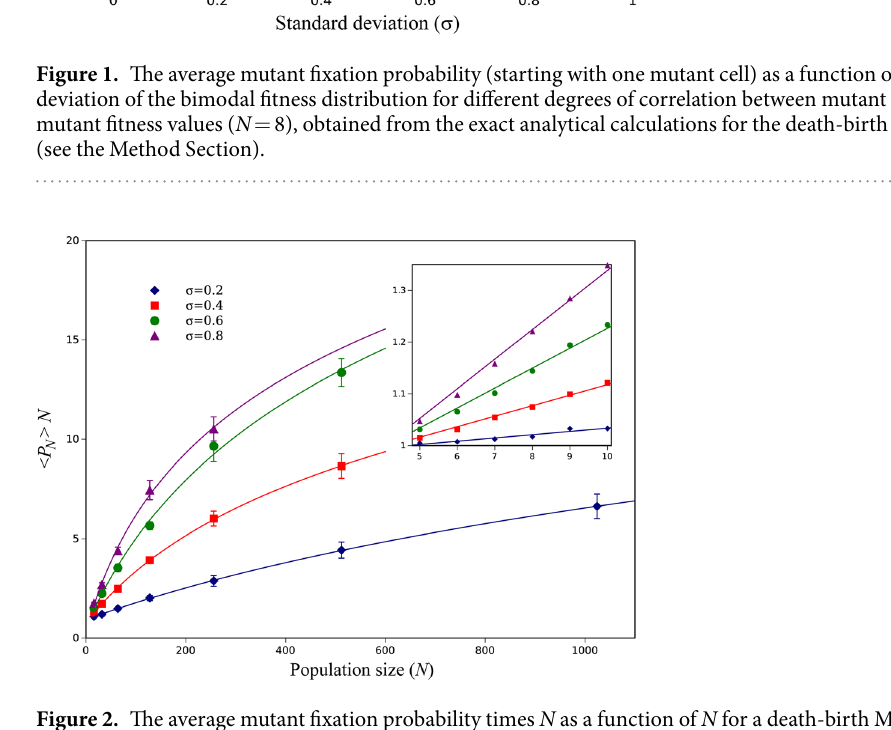
Figure 2. The average mutant fixation probability times N as a function of N for a death-birth Moran process in a circle. The fitness of both mutants and wild types comes from the same probability distribution and is given by 1 − σ and 1 + σ with equal probability (the bimodal distribution). For a neutral mutant, this function is expected to look like a horizontal line at level 1; a deviation from horizontal indicates selective advantage. The inset shows the behavior for small values of N . The points in the main figure as well in the small internal figure are based on stochastic simulations and error bars are standard error of the mean for a set of 5 realizations. The solid curves in the main figure are based on fitting the numerical simulation data to logarithmic functions. In the small internal figure, curves show the results of exact analytic